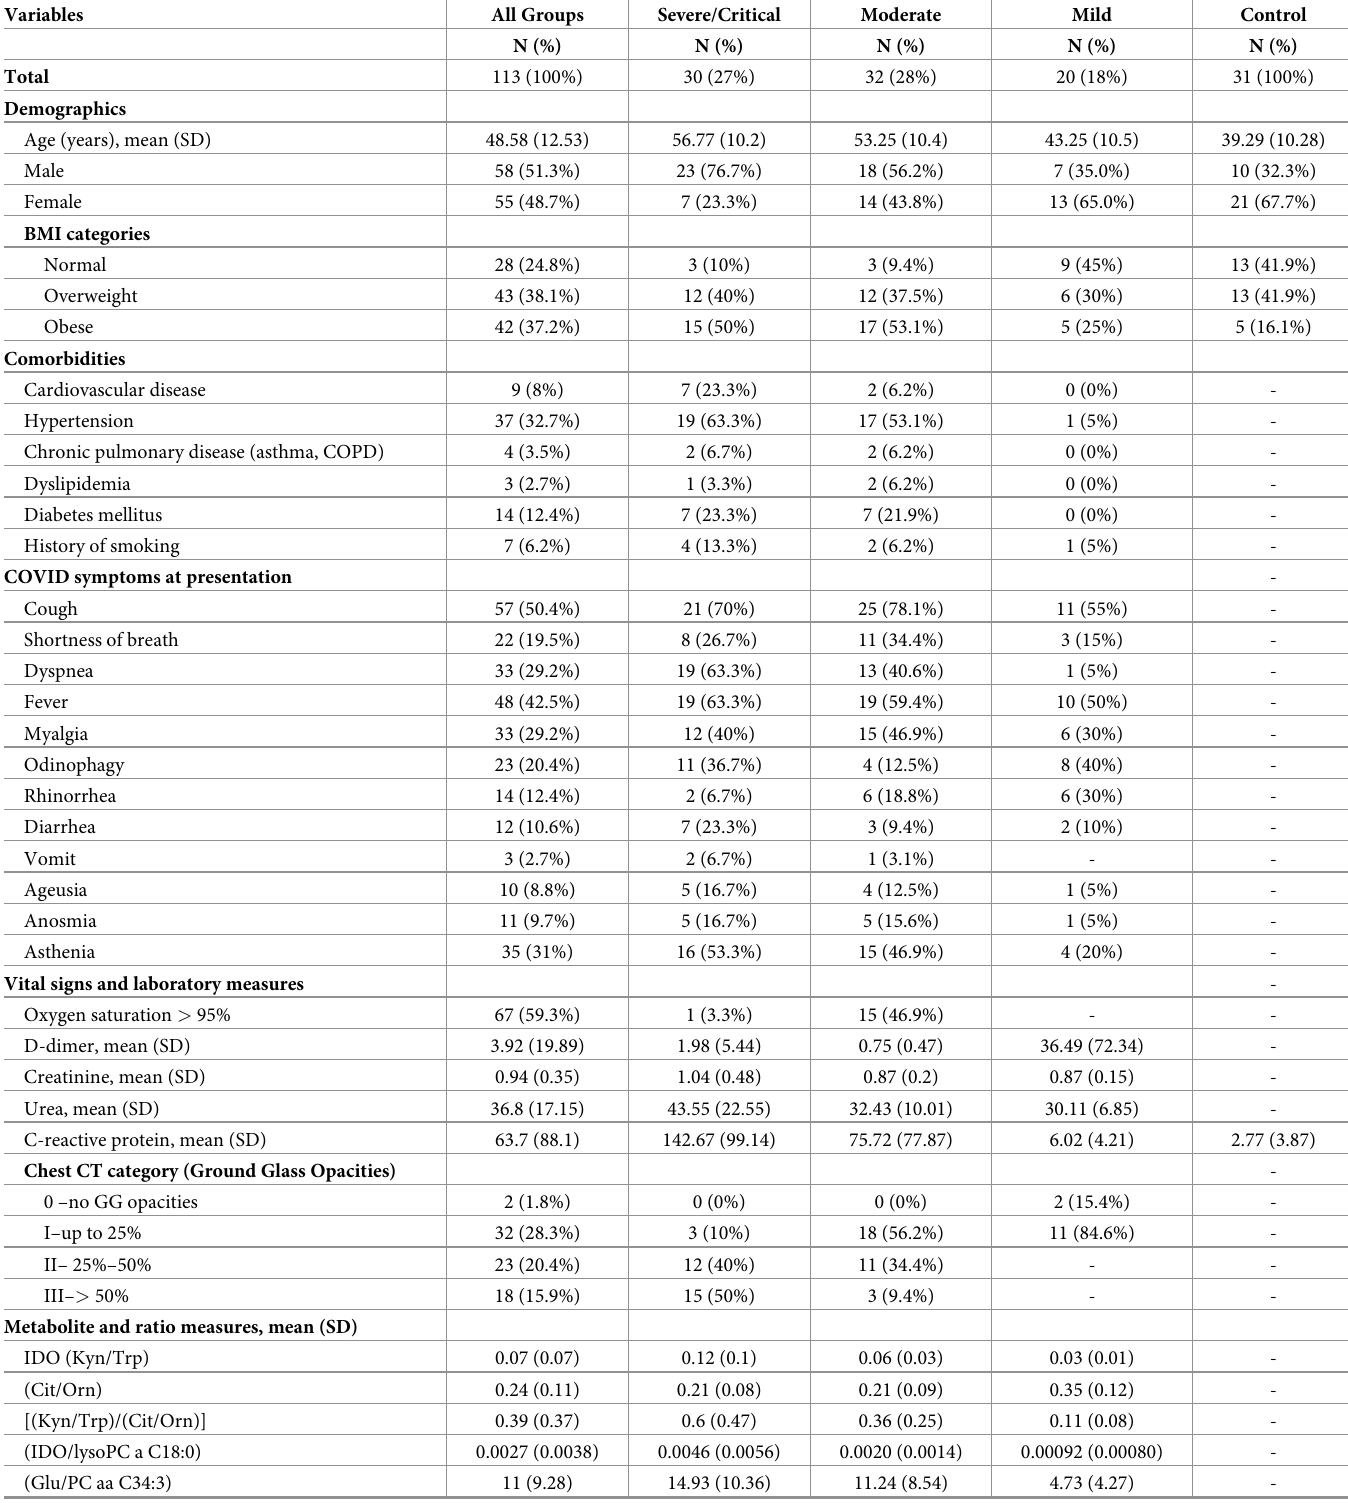
Table 1. Patient demographics and clinical